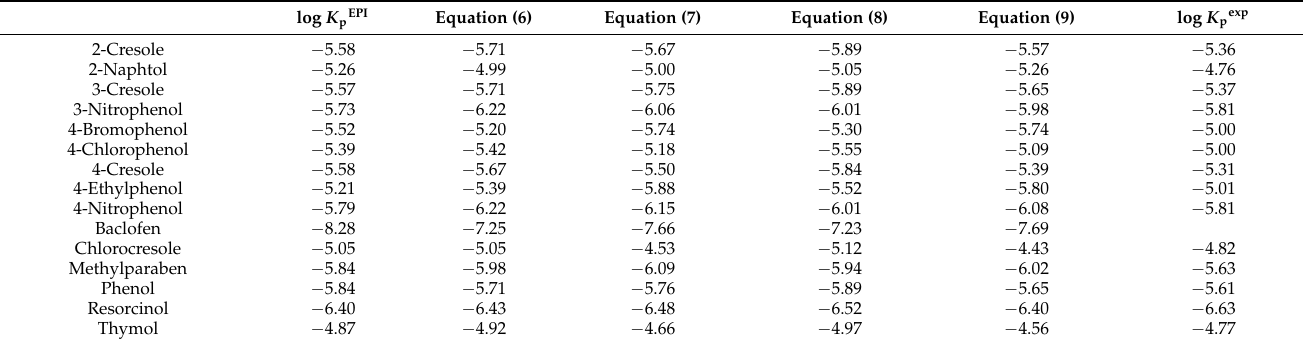
Table 2. Reference (EPI), predicted, and experimental values of log K p